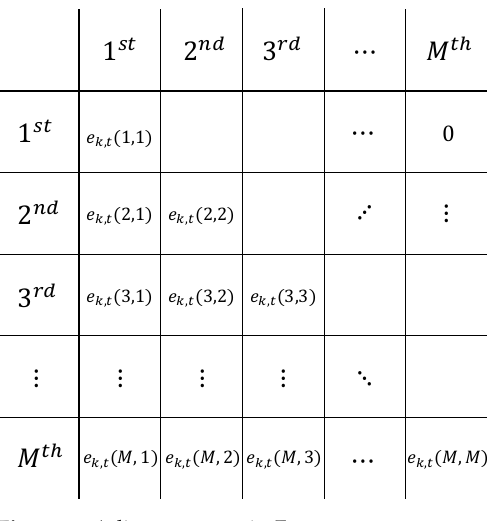
Figure 1. Adjacency matrix E k , t